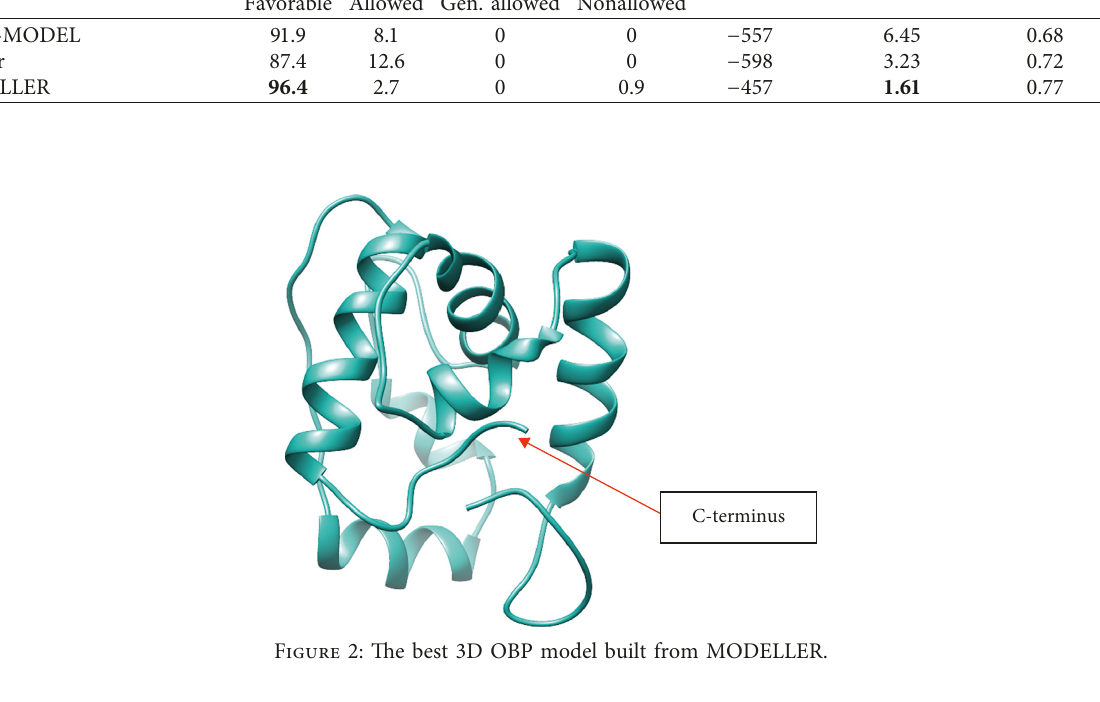
Table 1: Overall evaluation of the 3D comparative models generated from three different methods. Comparative modeling software